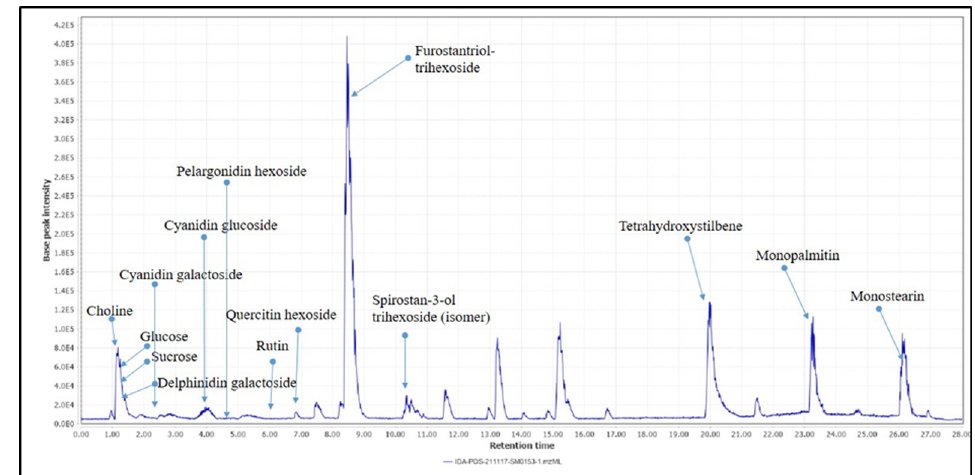
Fig 3. BPC of Yucca aloifolia fruit extract in positive ion